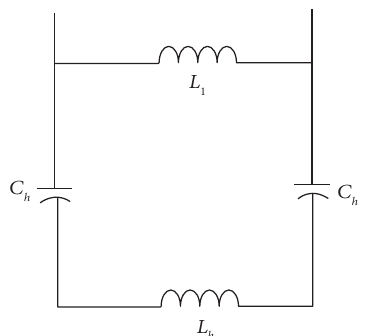
Figure 3: Equivalent circuit of the proposed reflector-backed antenna.